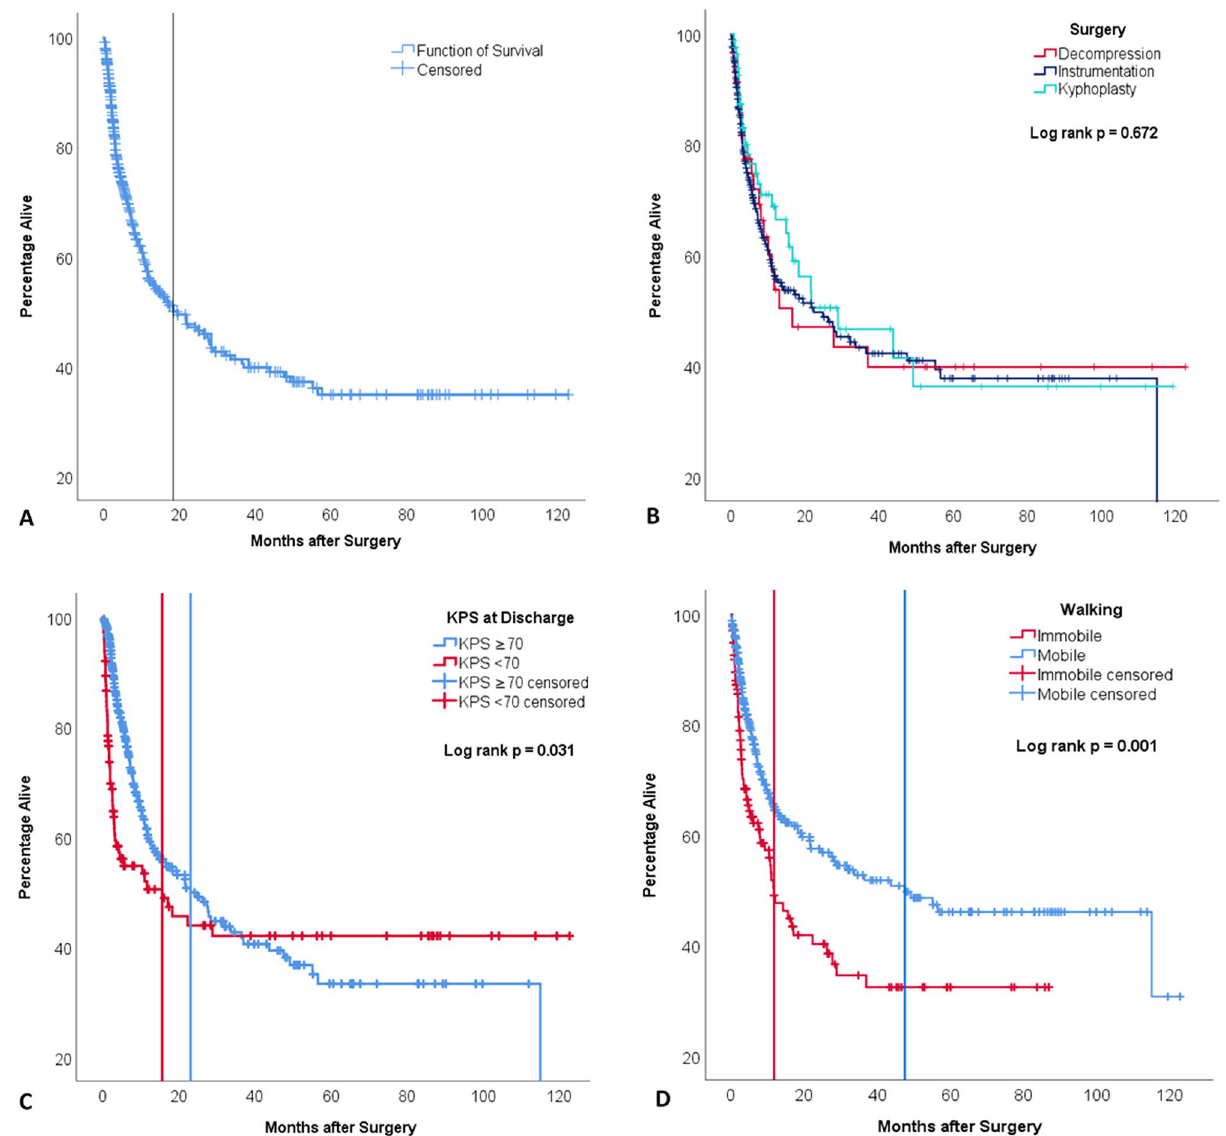
Figure 3. Kaplan–Meier estimation models of overall survival for the entire cohort (A) , stratified by surgical procedure performed (B) , functional status as per Karnofsky Performance Score at discharge (C) and ability to walk without aid by discharge (D) . Log rank test of statistical differences between means of subgroups performed for (B,C,D) . Vertical lines in (A,C,D) representing median overall survival. KPS Karnofsky Performance Scale score.